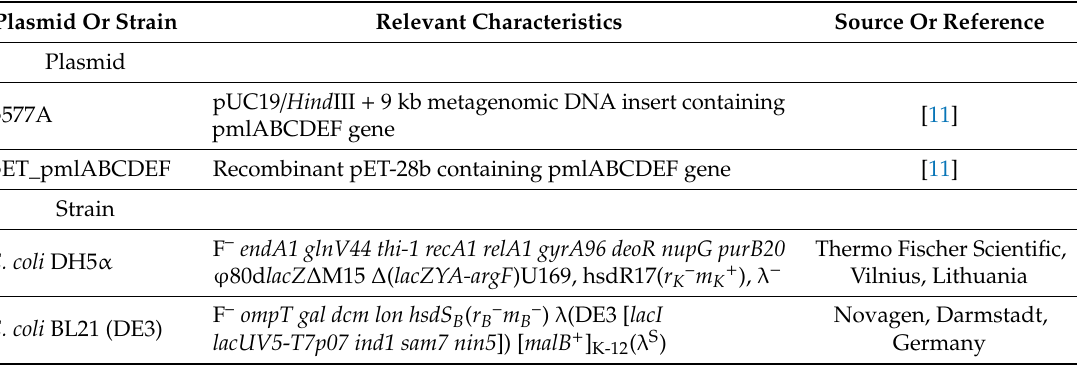
Table 3. The characteristics of the strains and